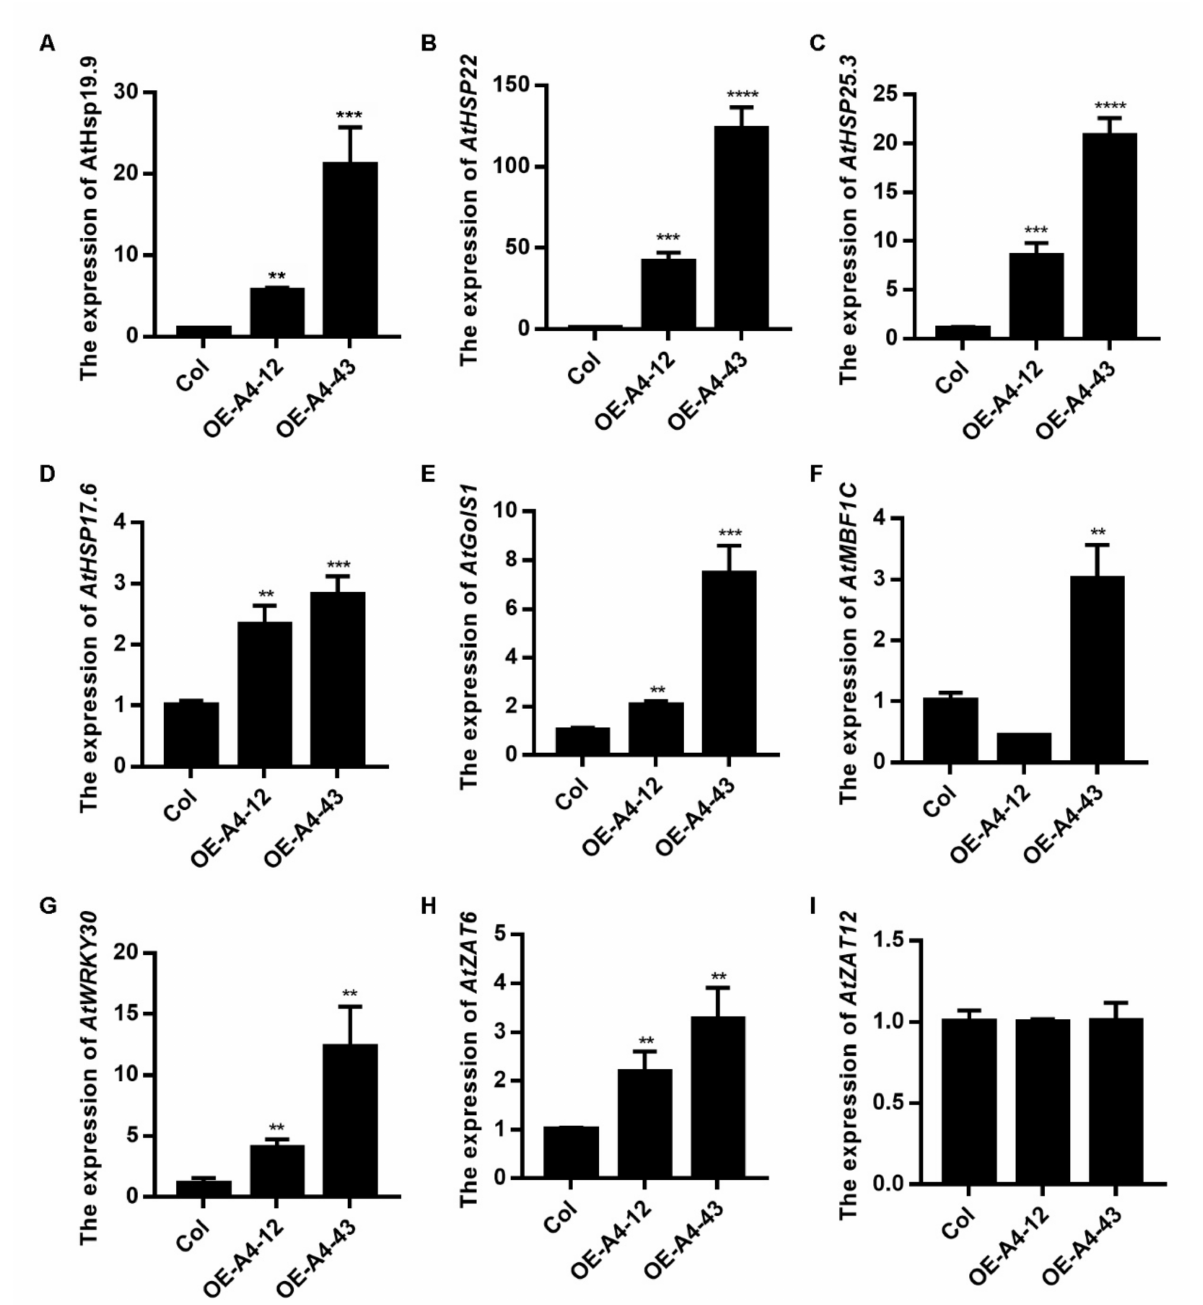
Figure 7. Expression of target genes was examined in LlHsfA4 transgenic plants. ( A – I ) showed the expression levels of 9 target genes..The mRNA level of target genes was detected in wild type (Col) and transgenic lines using qRT-PCR. The expression value of these genes in Col was set as1 for comparison and AtACTIN2 was used as an internal standard. 10-day-old seedlings were collected for RNA extraction. Three independent experiments were performed, each with three technical replicates, showing one experiment result. t -test analysis of variance was employed to identify treatment means that differed statistically. Samples with different letters are significantly different: ** p < 0.01, *** p < 0.001, **** p < 0.0001, Unmarked means